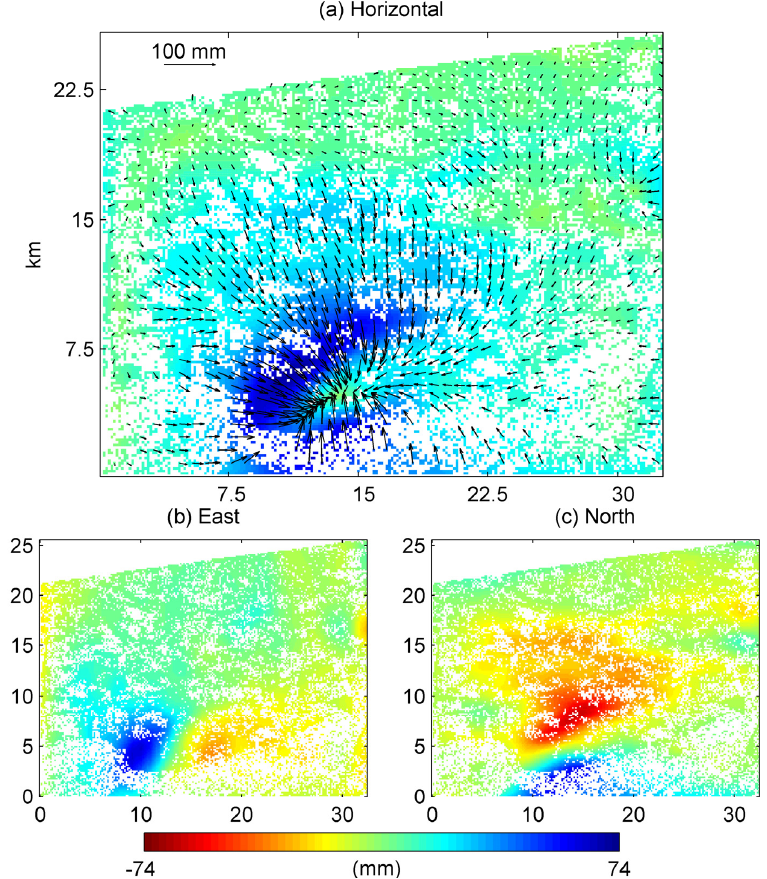
Figure 8. Modeled annual: ( a ) horizontal displacements; ( b ) horizontal displacements in E-W direction; and ( c ) horizontal displacements in N-S